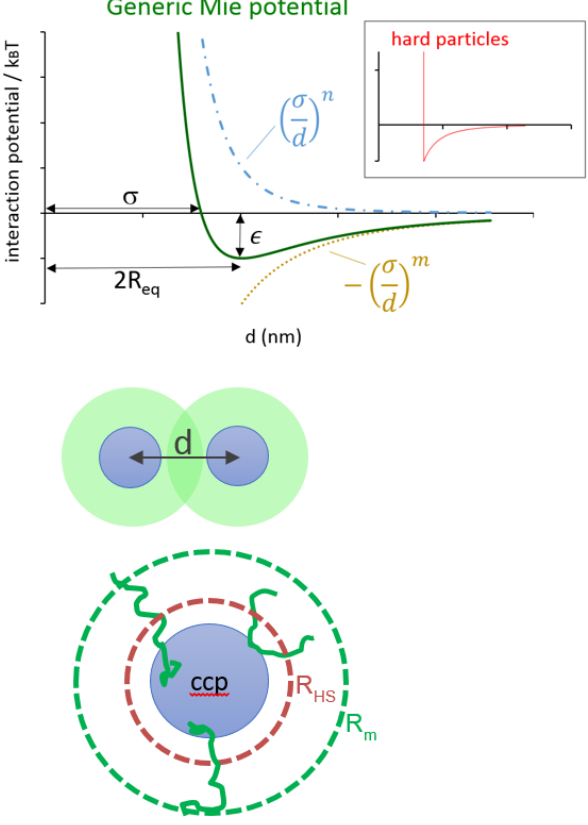
Figure 3: Schematic of the Mie potential and its repulsive and at- tractive components contrasted against an analogous hard particle system. The structure of the calcium protein assembly, and the sym- bols describing it. For visual clarity the protein – calcium assembly is drawn with only 3 proteins to give f = 4